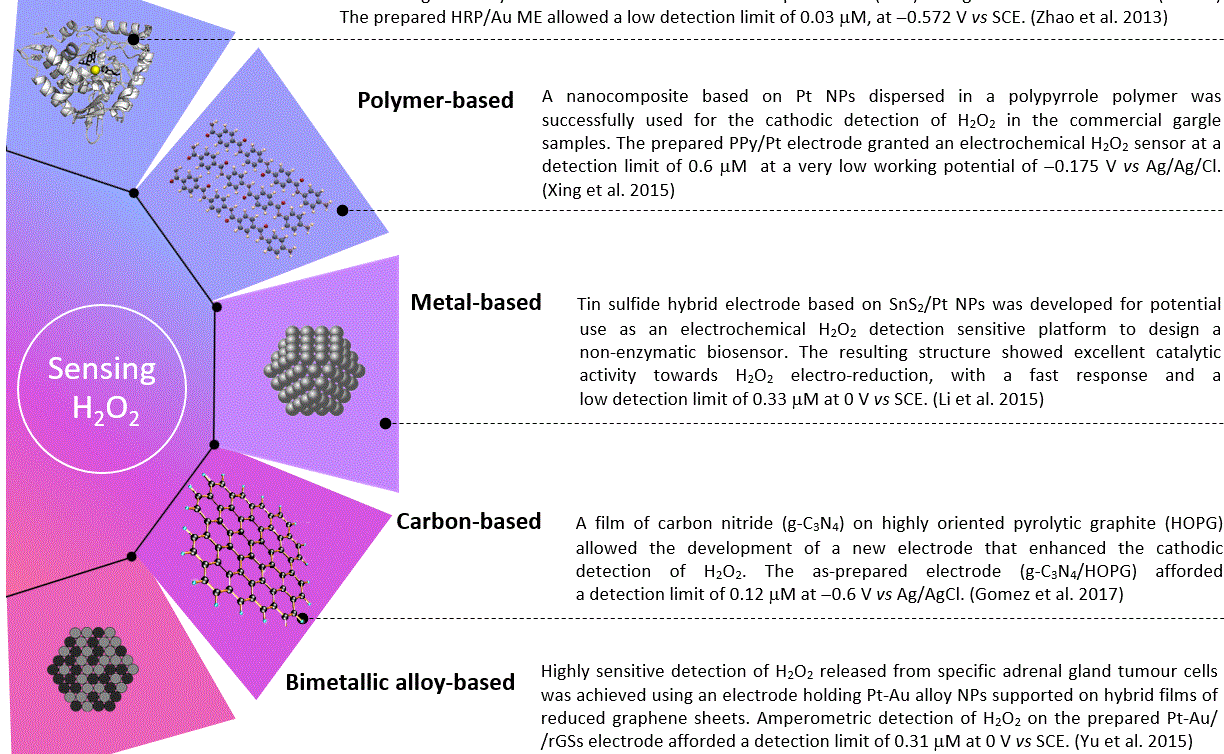
Figure 1. The different electrodes commonly used for the sensitive detection of H 2 O 2 . Collected data from the research works of Zhao et al. [35], Xing et al. [86], Li et al. [63], Gomez et al. [59], and Yu et al. [69].